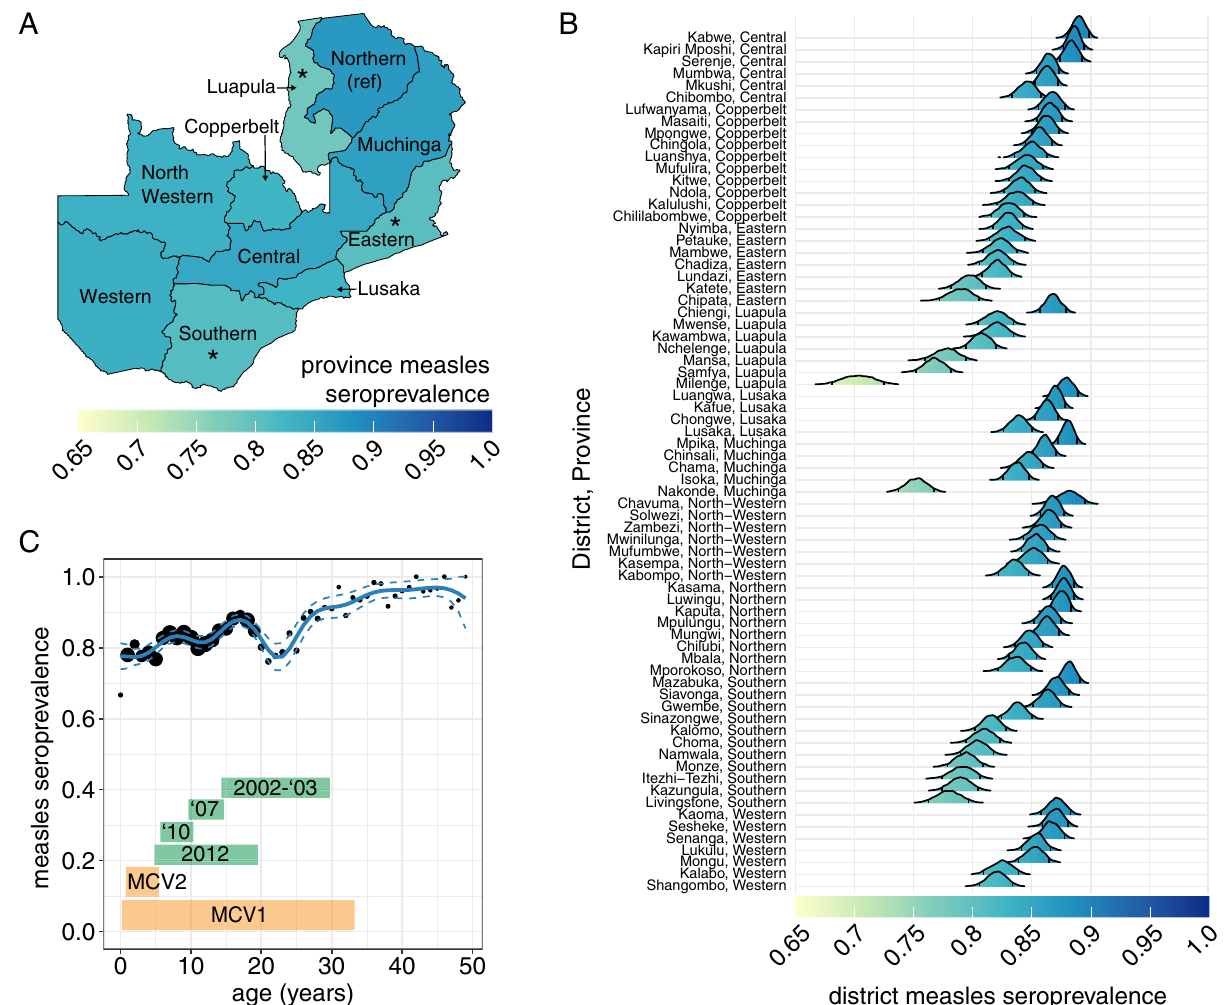
Figure 1. Measles seroprevalence. ( A ) Province seroprevalence. The asterisks represent provinces that had significantly different seroprevalence than the reference province, Northern Province (0.05 alpha level). ( B ) District seroprevalence. The distribution of district-specific seroprevalence estimates based on a hierarchical spatial model. The left and right vertical lines within each distribution represent the 5th and 95th percentiles. ( C ) National age-specific seroprevalence. The points represent the data grouped by age in years with the exception of year 0 which includes only individuals 10 and 11 months old and the size of the point is proportional to the number of observations in each age group (seroprevalence estimates for individuals younger than 10 months were collected and are show in Fig. S8). The blue lines represent fitted generalized additive model mean (solid line) and 95% confidence intervals (dashed lines). The age cohorts eligible for vaccination campaigns by campaign year (green boxes) and routine doses of measles-containing vaccine dose 1 (MCV1) and dose 2 (MCV2) (orange boxes) are